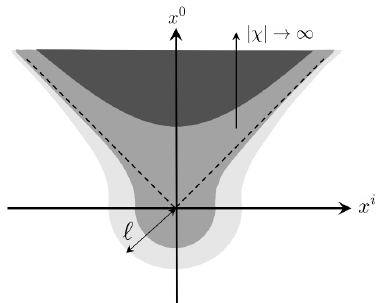
Figure 8 . In the lower part, we illustrate the Euclidean solution, which has an SO( d ) symmetry in d dimensional Euclidean space. We can then continue the solution into Lorentzian signature, as shown in the upper half of the figure. The analytic continuation of the winding mode becomes large in the region where the color gets darkest, and we cease to trust the solution there. In the figure, x 0 is the time direction of the d dimensional spacetime, while x i , i = 1 , . . . , d − 1 represent the